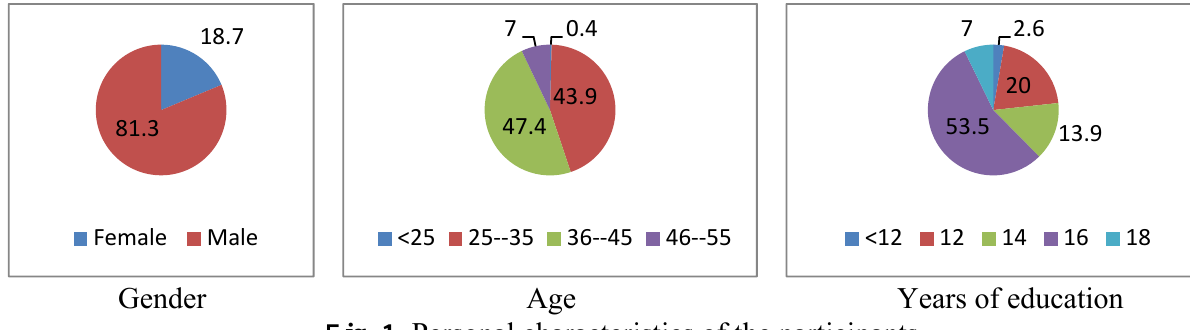
Fig. 1. Personal characteristics of the